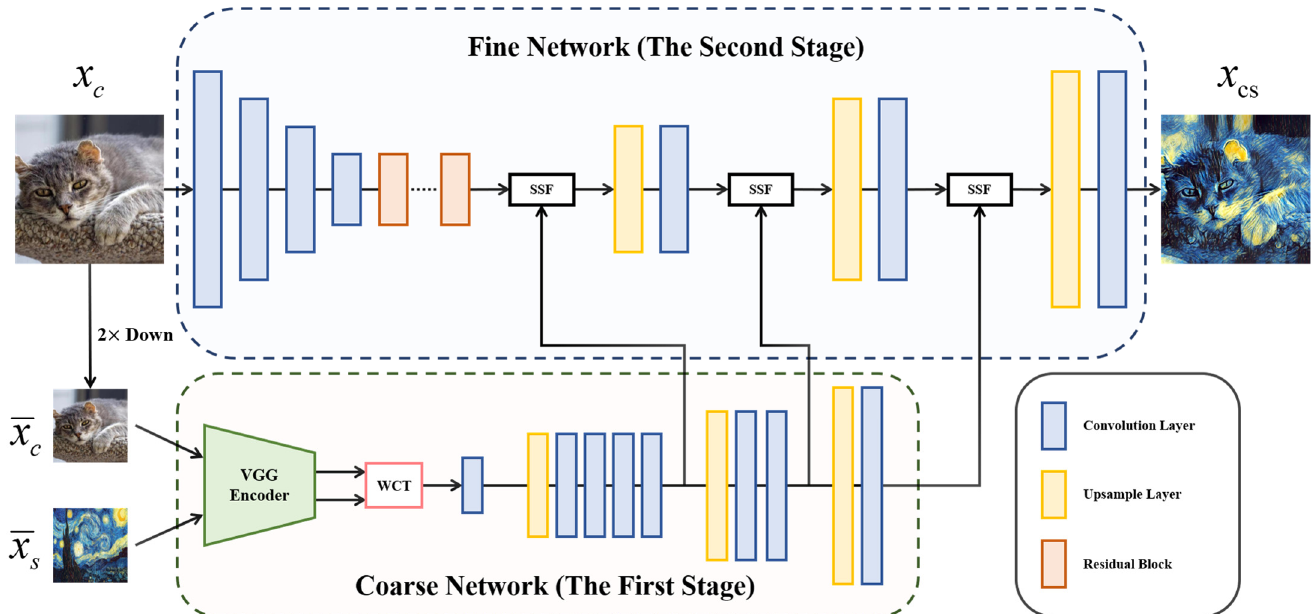
Figure 1. Overview of our framework.